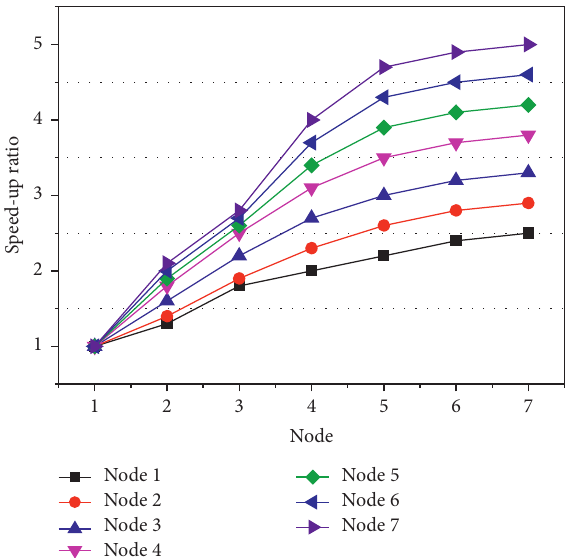
Figure 8: Acceleration ratio test